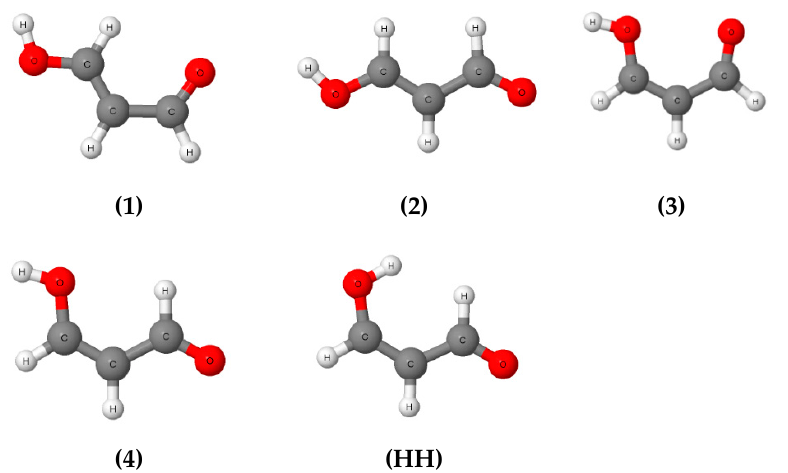
Figure 4. Conformations of malonaldehyde where intramolecular hydrogen bond does not occur, des- ignated by 1 , 2 , 3 and 4 numbers, as well as by HH that corresponds to a conformation characterized by the H ··· H